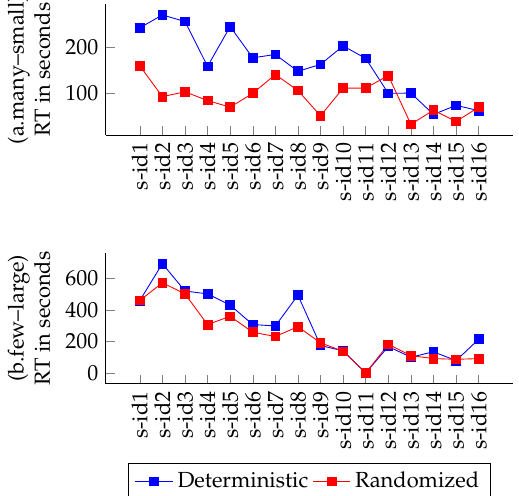
Figure 10. RT of the rounding techniques of R-ViNE-PS.